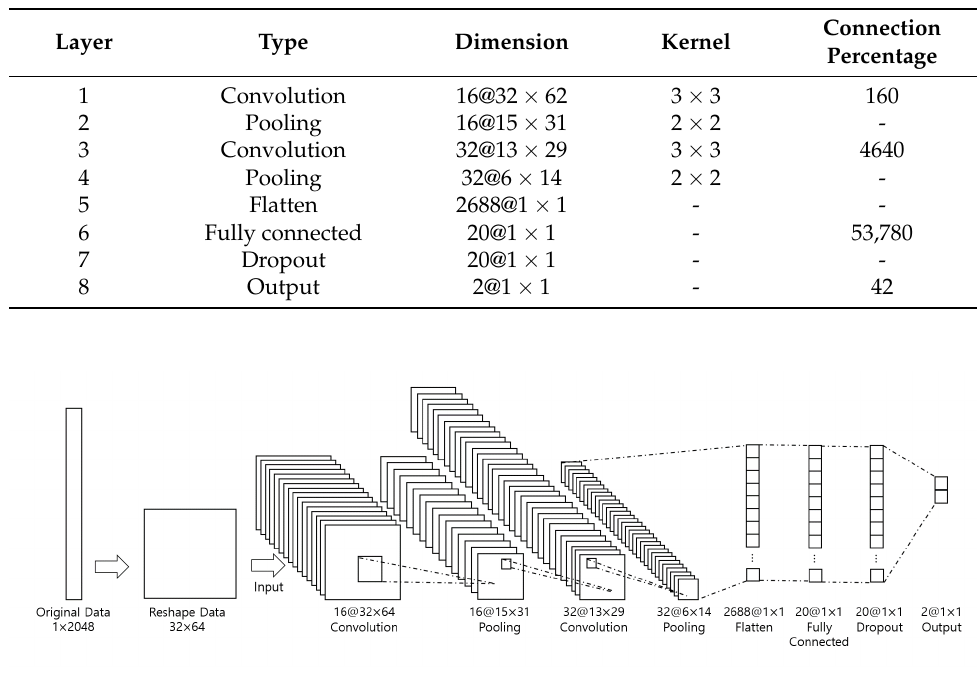
Table 1. Summary of the CNN model considered in this study.